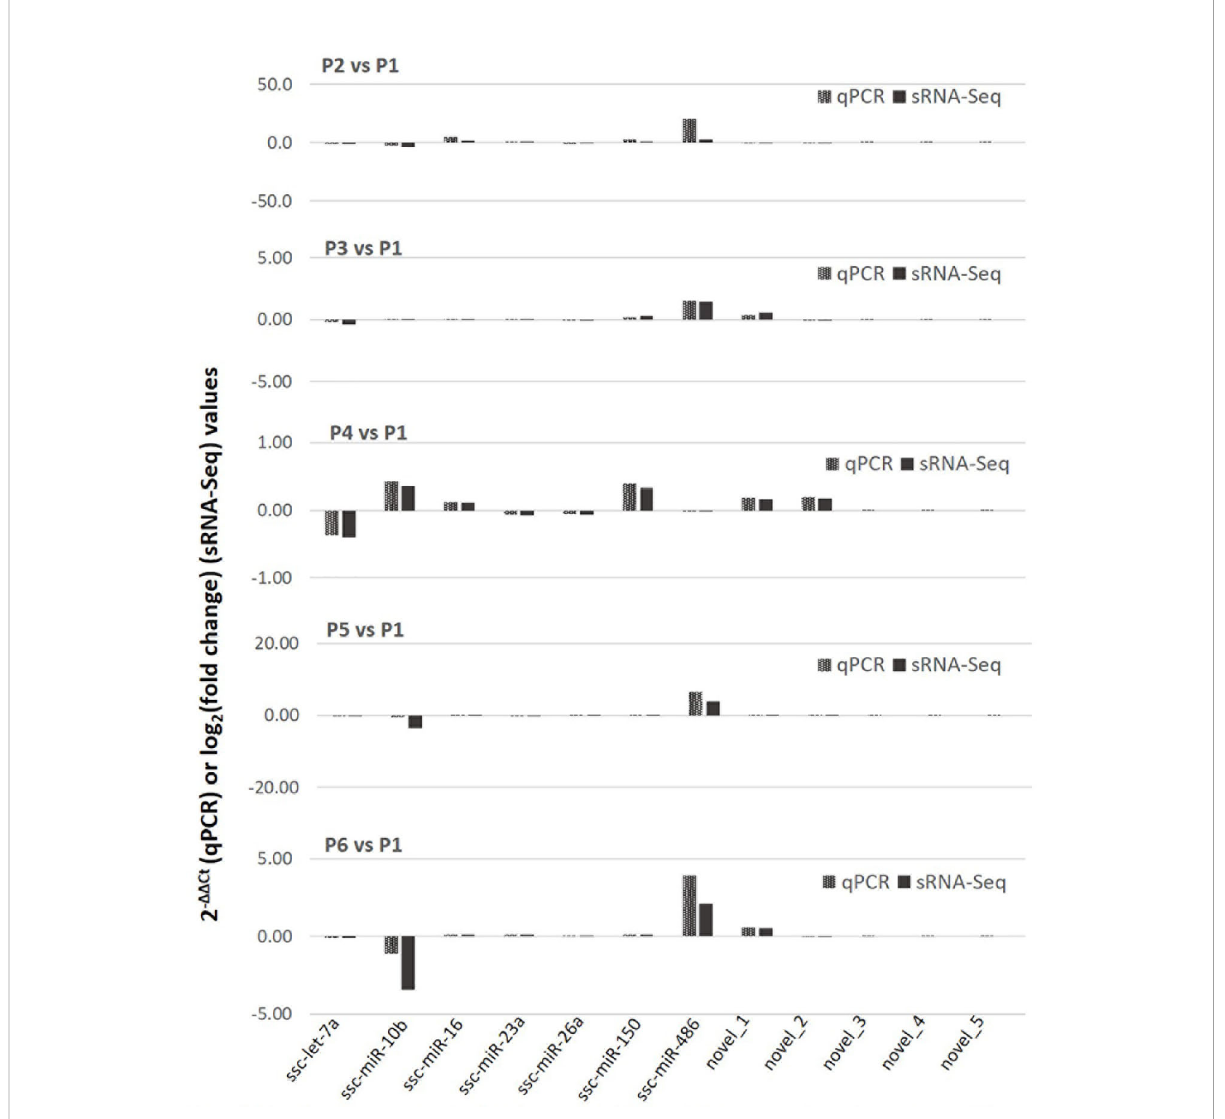
FIGURE 4 Differential expression of selected known and novel miRNA by sRNA-Seq was veri fi ed with a targeting quantitative RT-PCR (qPCR) assay. The y-axis scale indicates 2 − DD Ct (qPCR) or Log2(fold change) values relative to the control P1 sample. Aliquots of the cell RNA used for sRNA-Seq were analyzed using a SYBR green-based real-time RT-PCR assay. Ct values of the genes were normalized against Ct values of a housekeeping gene (coding for glyceraldehyde-3-phosphate dehydrogenase [GAPDH]) ampli fi ed from the same RNA samples to obtain 2 − D Ct and 2 − DD Ct relative to the control. Data shows a general consistence of the differential expression of both known and novel miRNA revealed by the